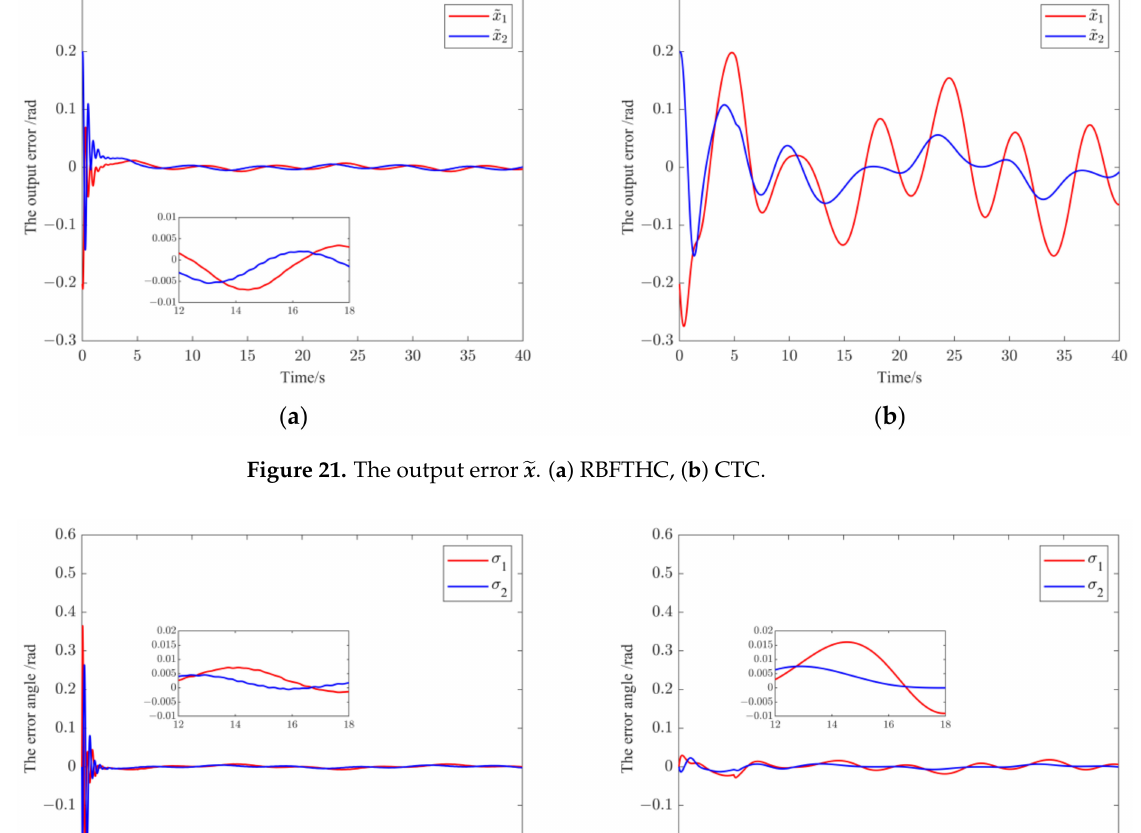
Figure 23. The joint angular velocity